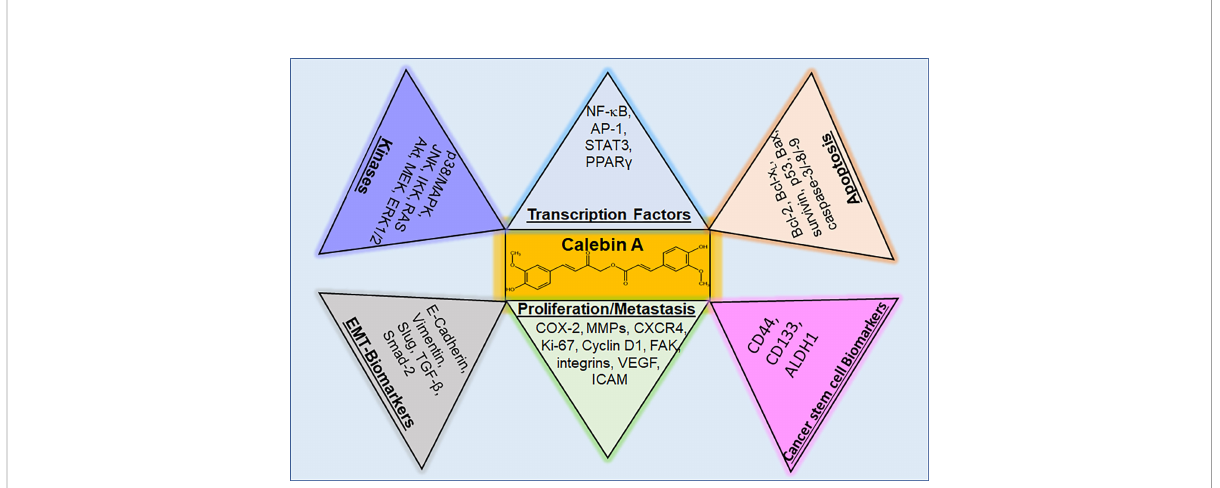
FIGURE 4 Regulatory molecular targets of Calebin A in cancer cells. Calebin A, as a multifunctional polyphenol, has the ability to modulate kinases and transcription factors, but also parameters for cancer stem cells, EMT, proliferation, metastasis and apoptosis in cells from different types of cancer. p38/MAPK, protein kinase of 38 kDa/mitogen-activated protein kinase; JNK, c-Jun N-terminal kinase; IKK, I k B kinase; RAS, rat sarcoma; Akt, serine-threonine protein kinase B; MEK, mitogen-activated protein kinase kinase; ERK 1/2, extracellular signal-regulated kinase; NF- k B, nuclear factor kappa-light-chain-enhancer of activated B-cells; AP-1, adaptor protein-1; STAT3, signal transducer and activator of transcription 3; PPAR g , peroxisome proliferator-activated receptor g ; Bcl-2, B-cell lymphoma 2; Bcl-xL, B-cell lymphoma-extra-large; Bax, Bcl-2-associated X protein; CD, cluster of differentiation; ALDH, aldehyde dehydrogenase; COX-2, cyclooxygenase-2; MMP-9, matrix metalloproteinase-9; CXCR4, C-X-C chemokine receptor type 4; FAK, focal adhesion kinase; VEGF, vascular endothelial growth factor; ICAM, intercellular adhesion molecule; TGF, tumor growth